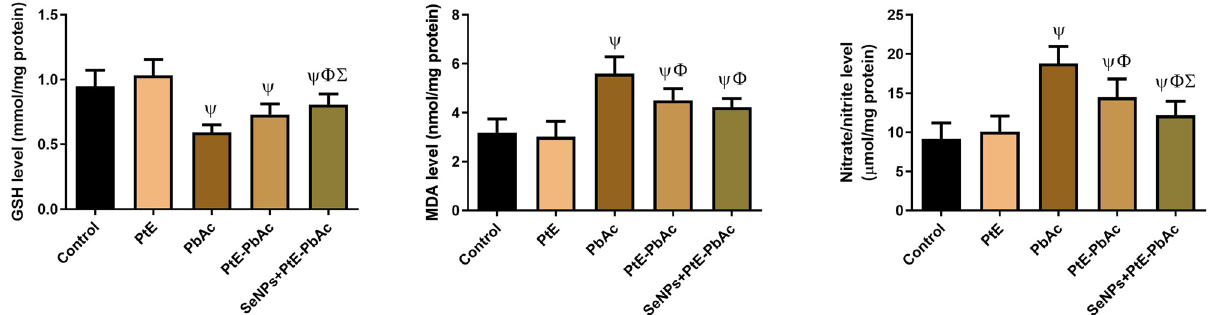
Figure 4: E ff ects of orally administered PtE or PtE - SeNPs on the levels of non - enzymatic oxidative stress markers ( GSH, MDA, and NO ) in the brain of PbAc - injected rats. ψ , Φ , Σ superscript letters indicate statistical signi fi cance at P < 0.05 against control, PbAc, and PtE - PbAc group, respectively. All results are presented as the mean + SD.